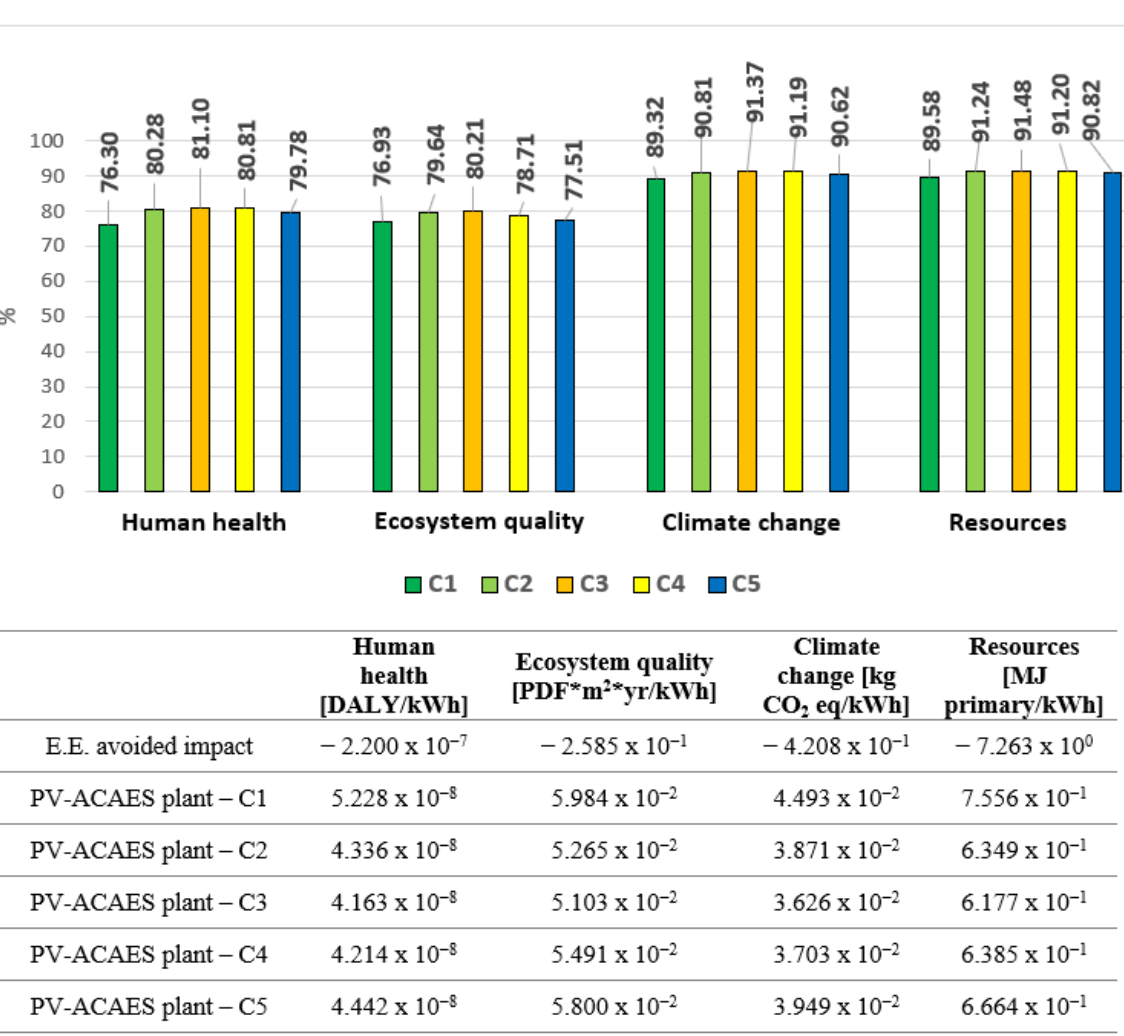
Figure 7. Impact category indicators for the PV-ACAES plants with underground air storage. The bar graph shows the impact reduction in comparison with the reference scenario.